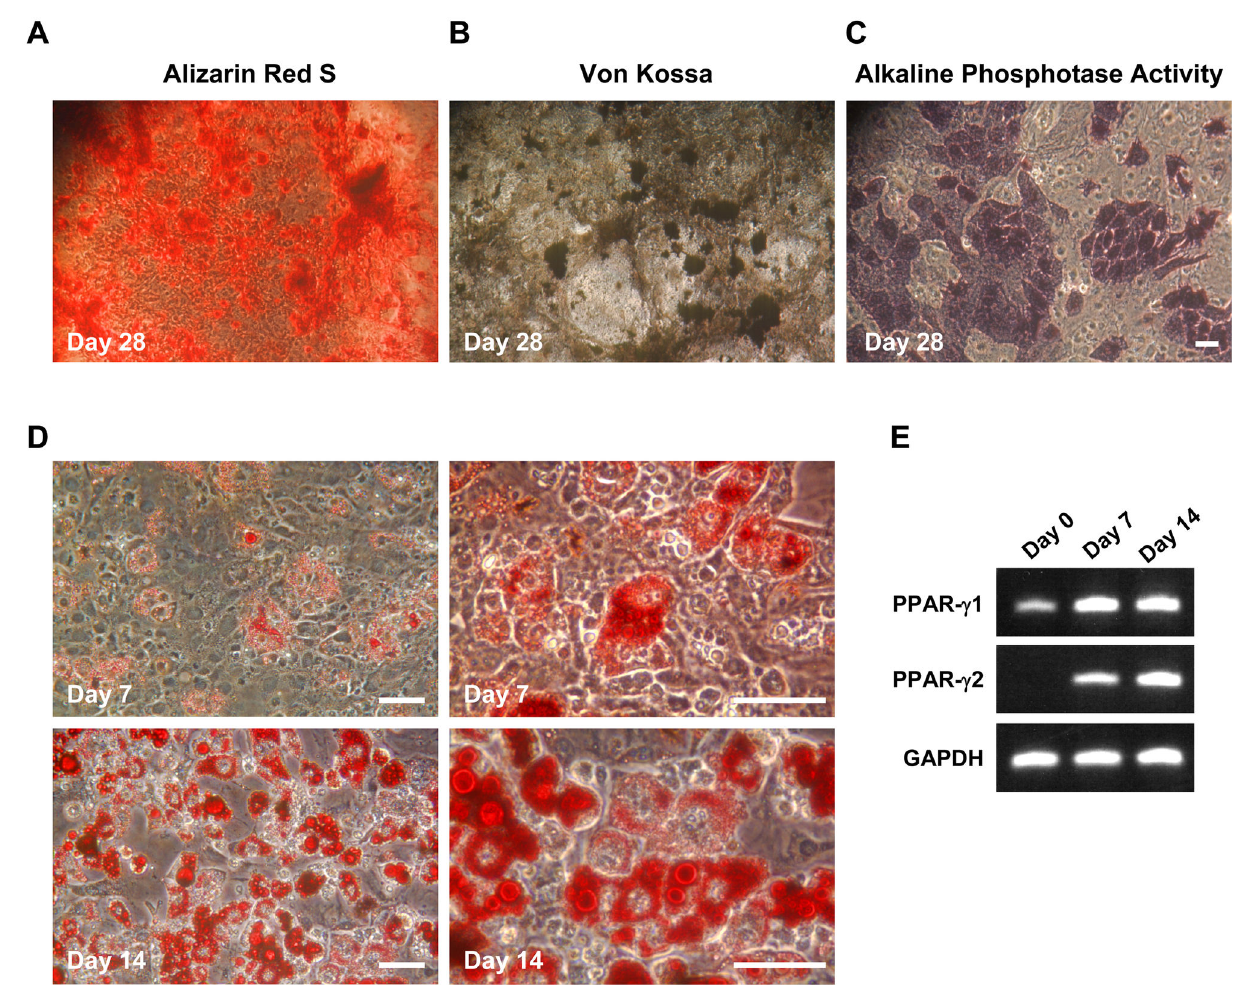
Figure 3. Mesodermal differentiation potential of mUC-MSCs. Osteogenic differentiation : Cells of passage number 12–20 were induced to form osteoblast by culturing in osteogenic induction medium for 28 days, followed by staining with Alizarin Red-S (A), von Kossa (B), and evaluated by alkaline phosphatase activity (C) for osteoblasts. Adipogenic differentiation : cells were induced to form adipocytes by culturing in induction medium for 14 days. Adipocytic differentiation is evidenced by the formation of oil droplets stained with Oil-red O. Panel D (right) displayed a higher-magnification image of cells. (E) Expression of adipocytic phenotypic markers PPAR-γ1 and PPAR-γ2 was assayed by RT-PCR. Scale bar = 50